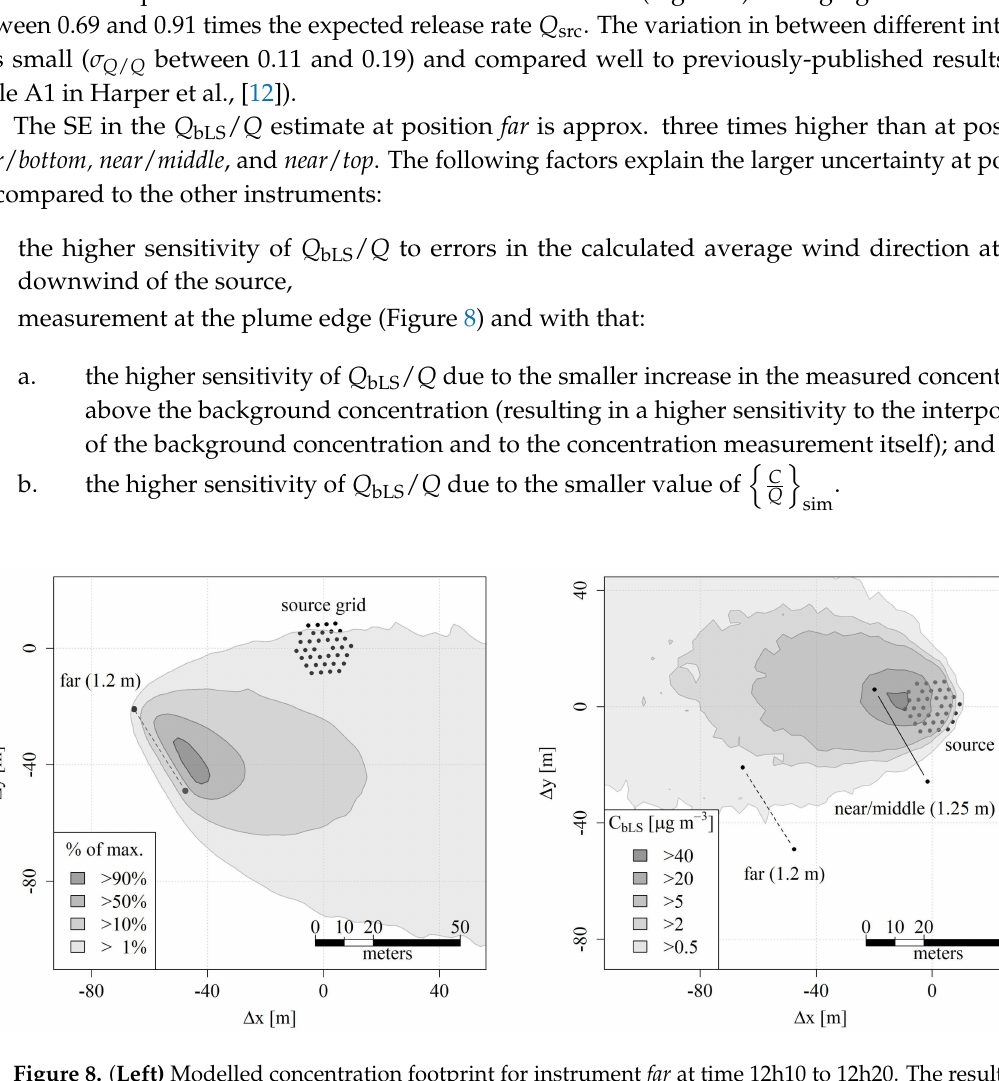
Figure 8. ( Left) Modelled concentration footprint for instrument far at time 12h10 to 12h20. The results from this interval were excluded from the analysis for location far . The grey areas indicate the spatial distribution of the relative contribution of surface fluxes to the concentration at position far (i.e., the concentration footprint). Wind is blowing from east ( β = 97 ◦ ), i.e., from right to left. ( Right) Modelled concentration distribution in the horizontal plane at height 1.2 m a.g.l. between 12h10 and 12h20, assuming an emission rate identical to the source release of 6.29 mg NH 3 s − 1